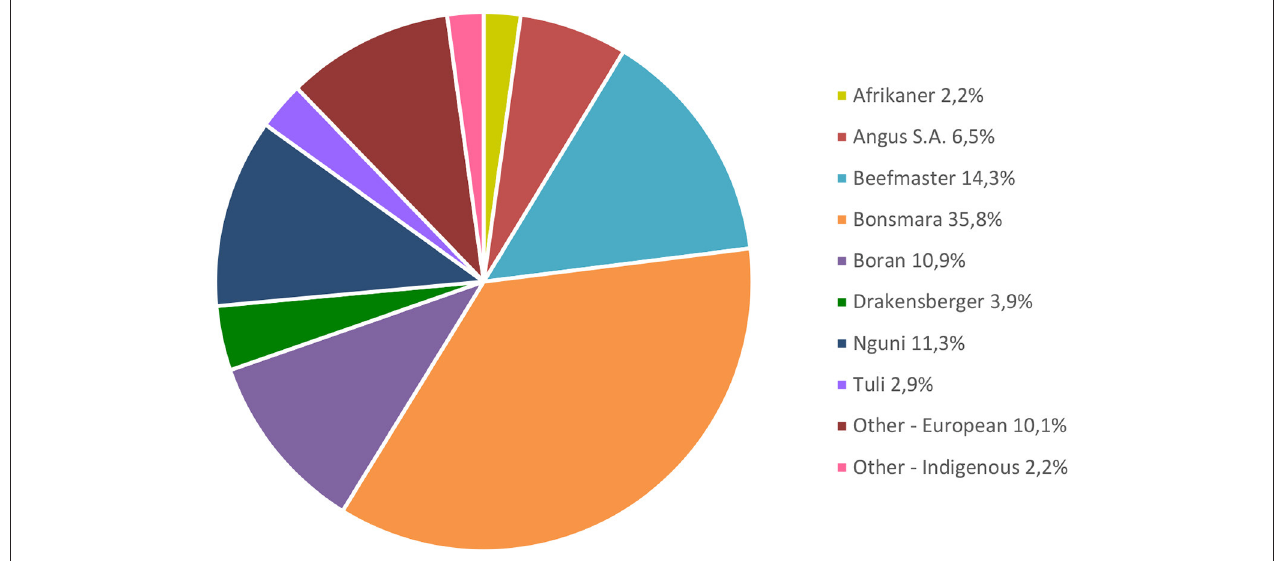
FIGURE 2 | Percentage registered beef cattle participating in Logix Animal recording (SA Stud Book Annual Report,